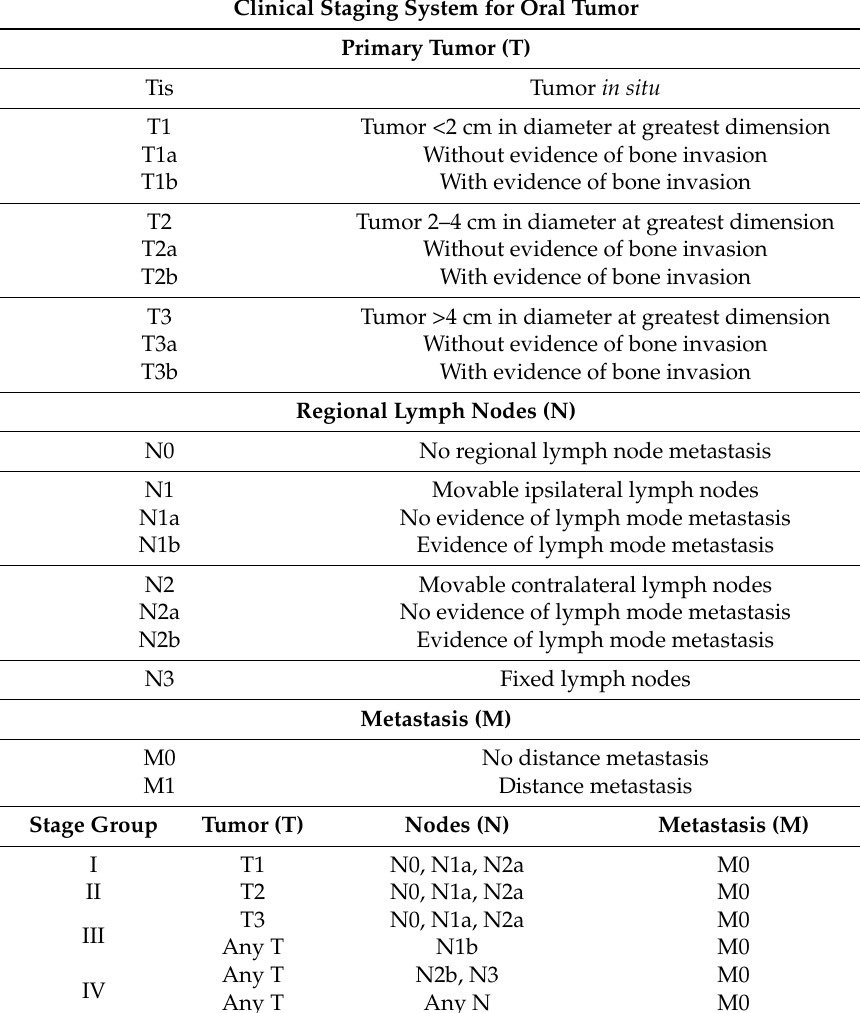
Table 3. TNM classification of tumors in domestic animals, WHO, Geneva,